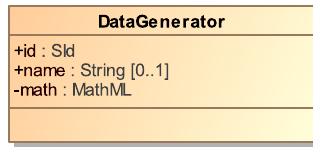
Figure 2.38: The SED-ML DataGenerator class